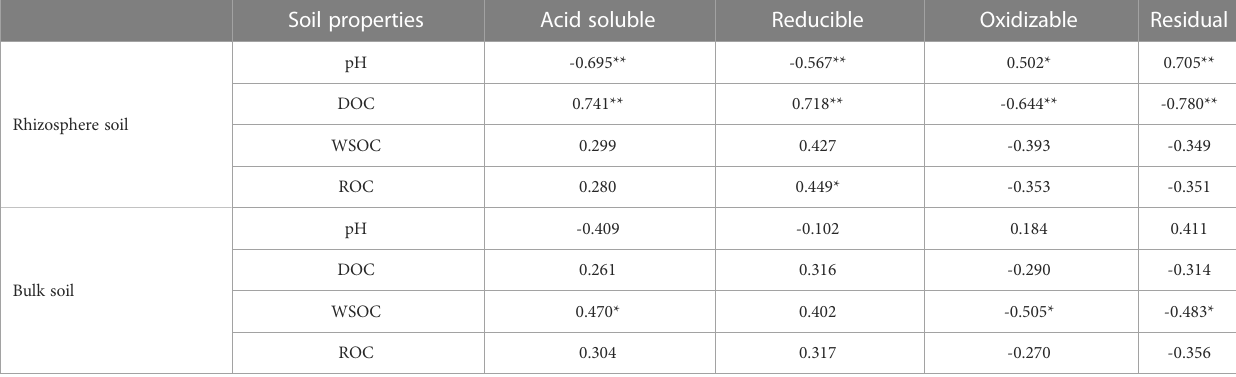
TABLE 2 Correlations between partial soil properties and Cd speciation in the rhizosphere and non-rhizosphere of S. orientalis across all samples.